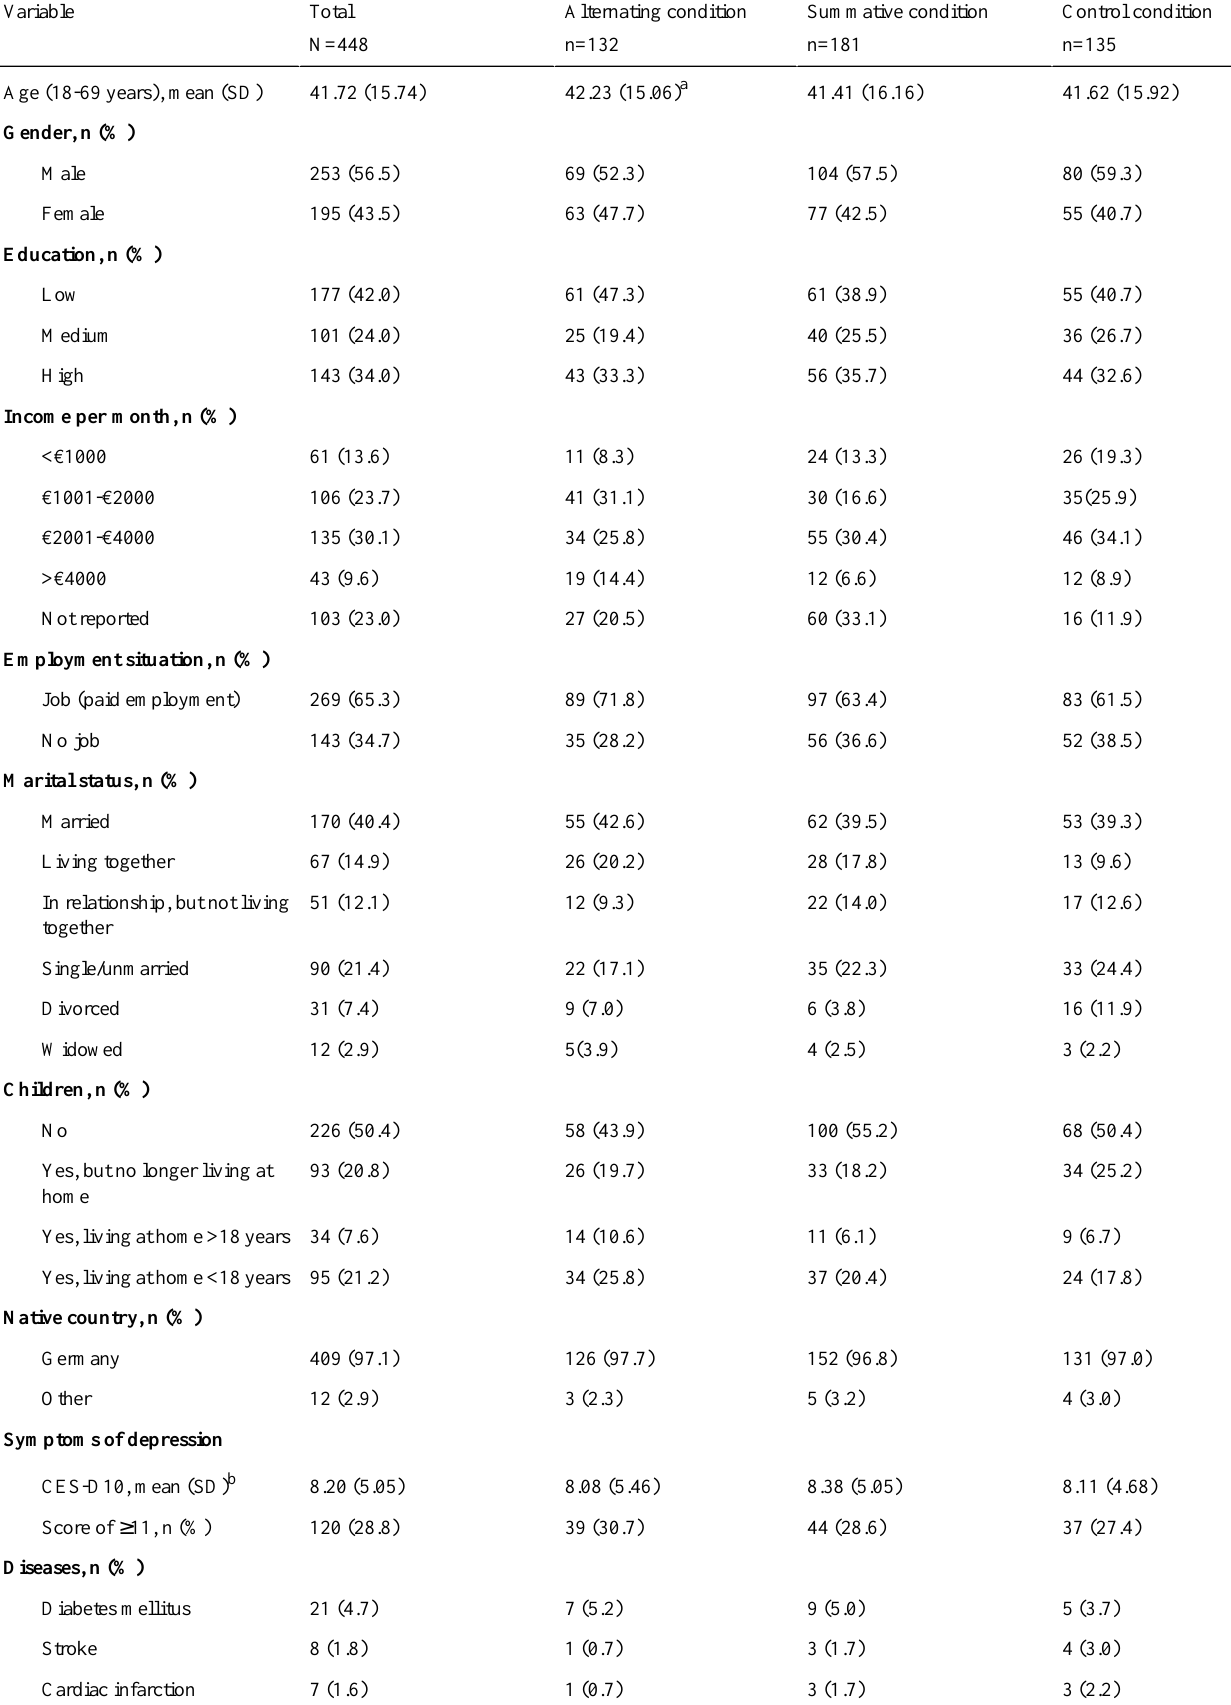
Table 1. Demographics, health status, and drinking behavior of the study sample at